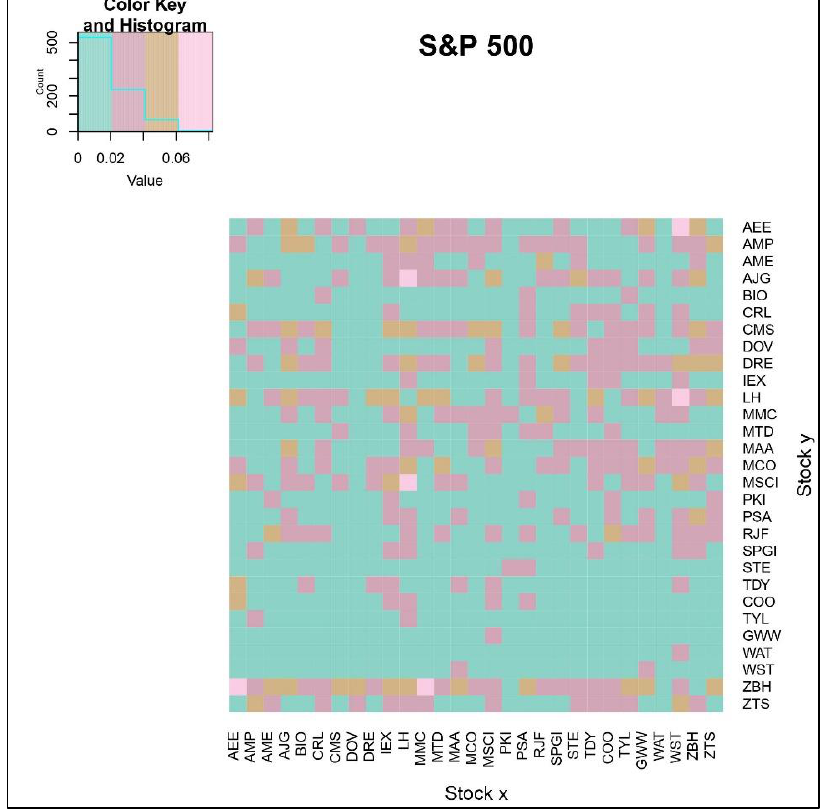
Figure 20. The information flow (effective transfer entropy) from stock y to stock x, for the top companies (by market capitalization) in the S&P500 market, after the COVID-19